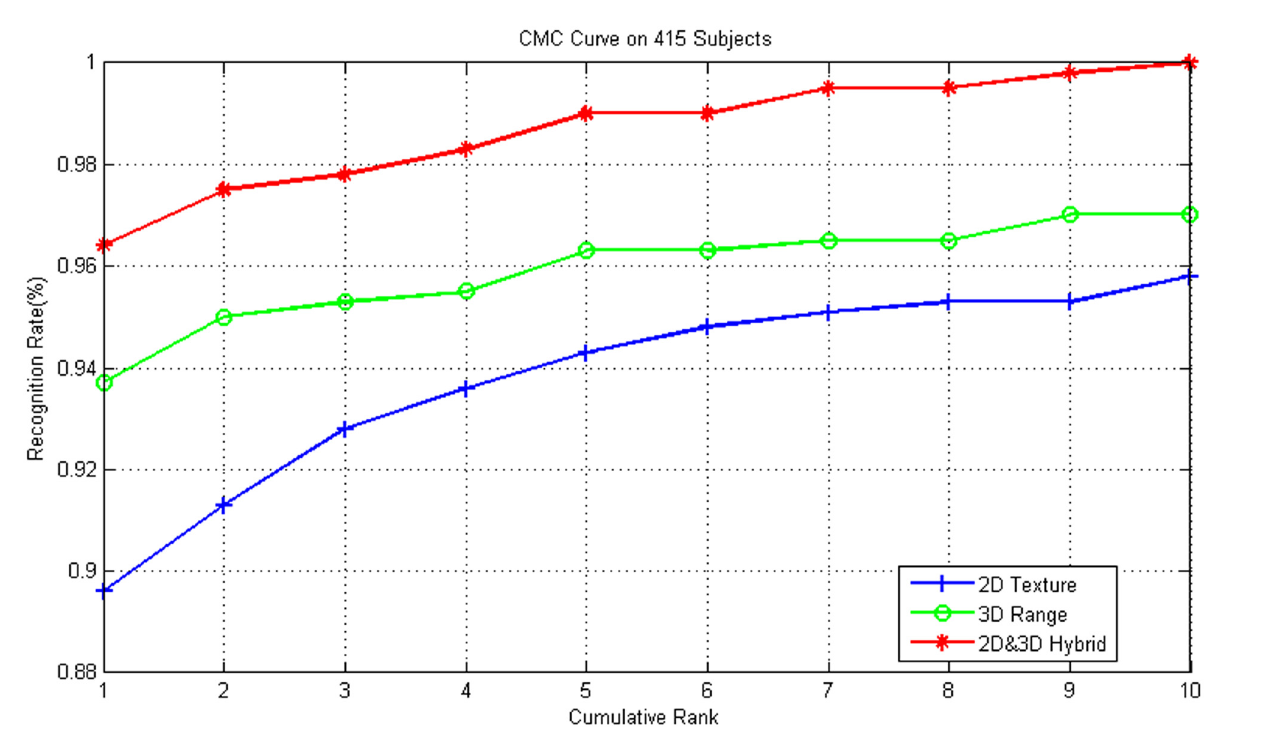
Fig 6. CMC curves on different data types.